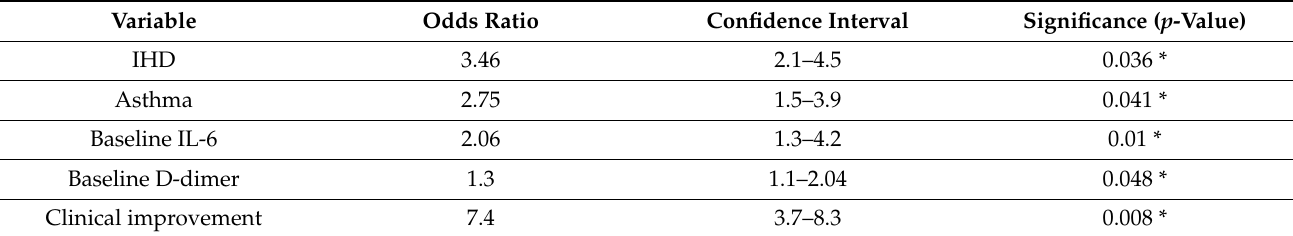
Table 5. Predictors of COVID-19 mortality by binary logistic regression.